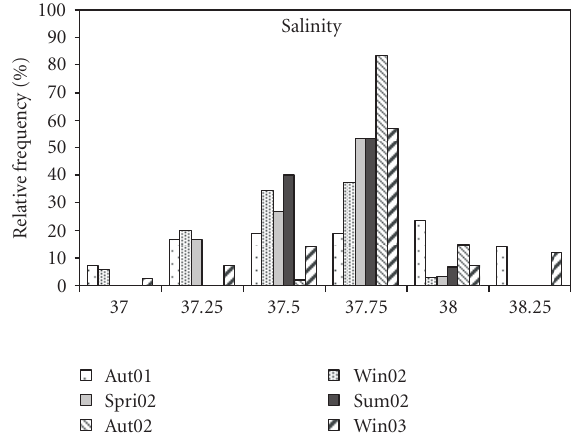
Figure 5: Salinity (PSU Units) seasonal distribution in frequency classes (autumn 2001–winter 2003). Labels report the class lower value.